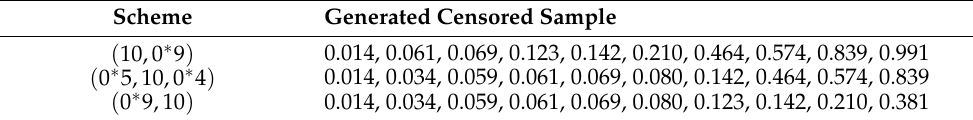
Table 5. Three different PFFC samples from the electrical appliances